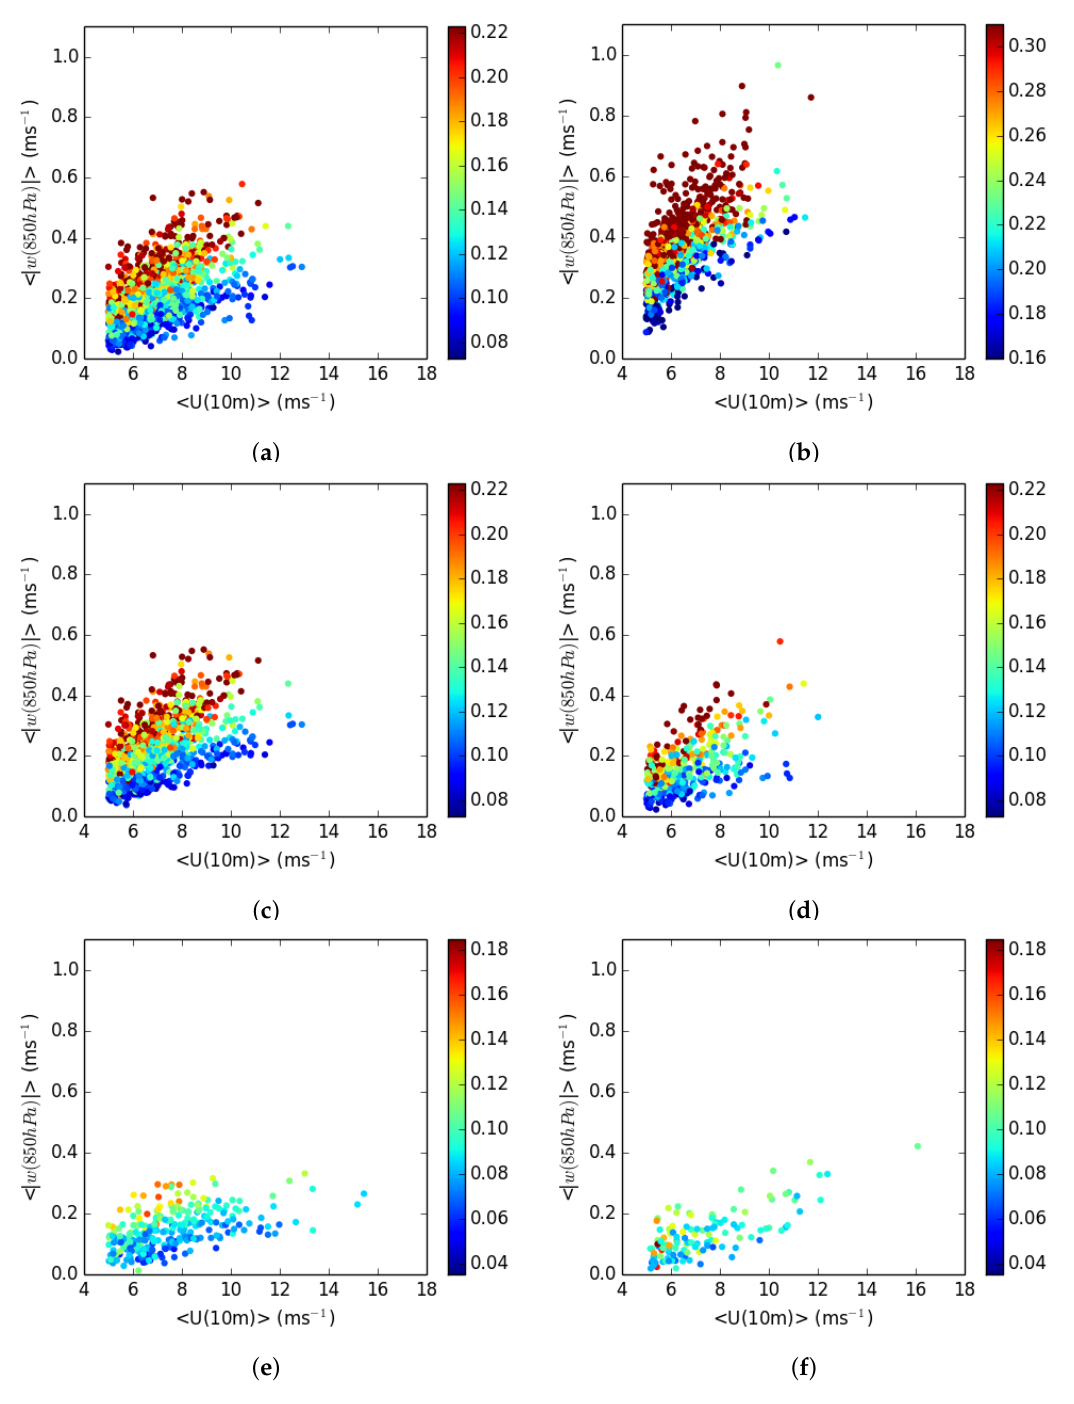
Figure 3. Variation of | w 850 hPa | as a function of | u 10 m | for 3DVOM forecasts from 2007–2010 for ( a ) the Pennines domain and ( b ) the Grampians domain. Values of | ∆ s | are highlighted using colour. ( c , d ) are as (a), but filtered for u 10 m containing (c) a westerly and (d) an easterly component. ( e , f ) are as (c,d), but for the Dartmoor